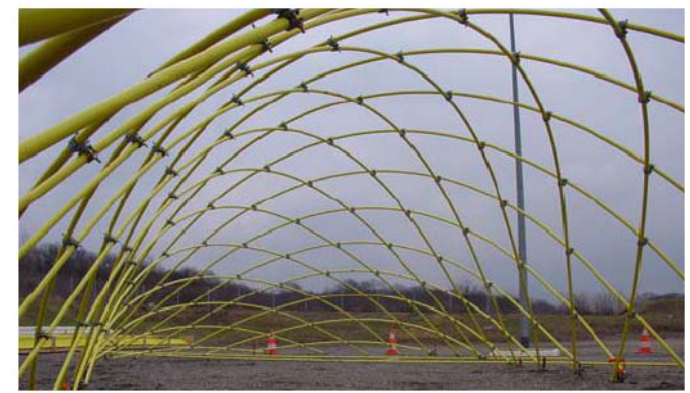
Figure 2. Single layer gridshell constructed of GFRP poles